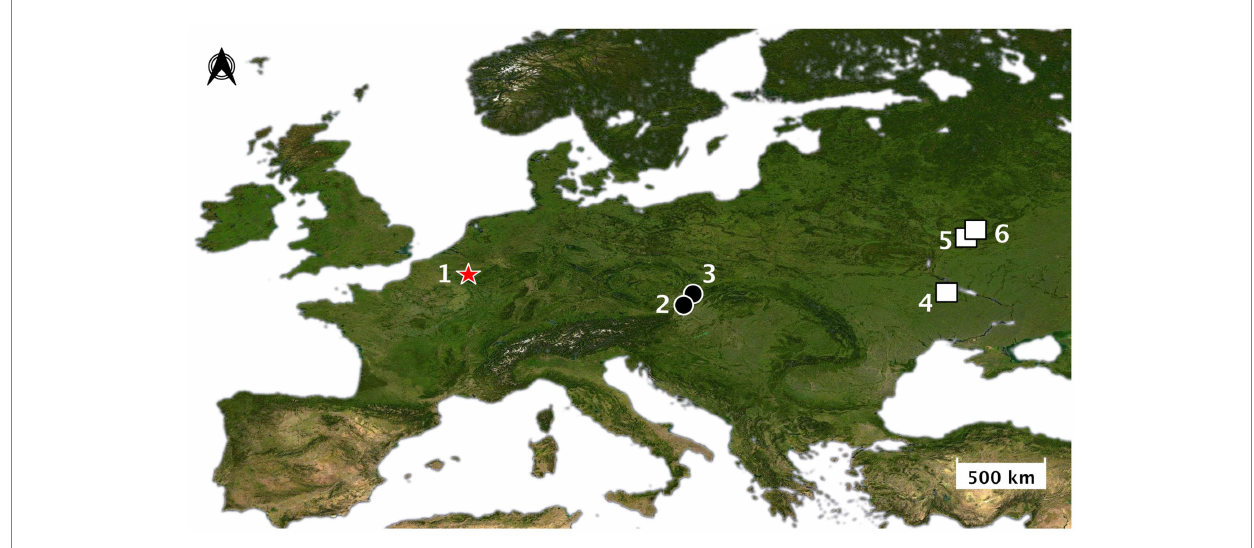
FIGURE 3 Map of Europe showing the location of sites mentioned: (1) Goyet; (2) Předmostí; (3) Dolní Věstonice; (4) Mezhirich; (5) Yudinovo; (6) Eliseevichi. Red star = Aurignacian sites; black circle = Gravettian sites; white square = Epigravettian sites. Base map: Europe-NASA-satellite. Credit: Elodie-Laure Jimenez.